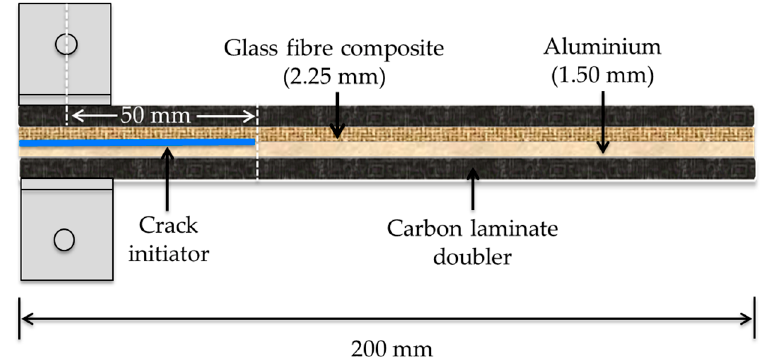
Table 1. Fibre Metal Laminate ( FML) variants investigated for mode I fracture toughness properties.